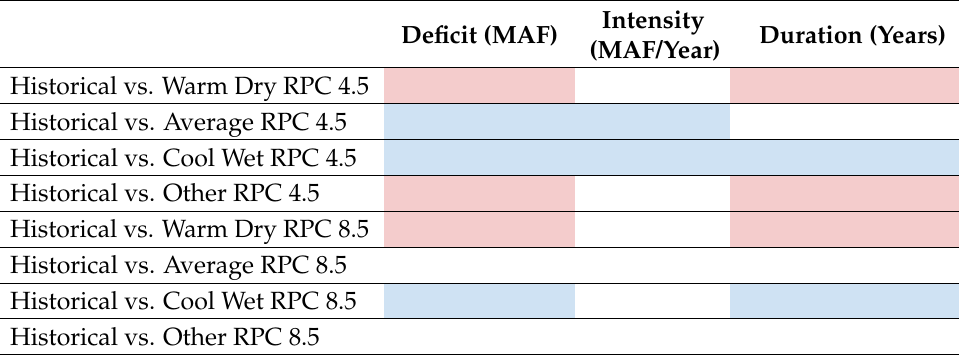
Table 1. Aggregated streamflow analysis using two tailed difference in means t -tests with a significant difference in drought categories. Highlighted boxes indicate a significant difference (at a 0.05 level) between historical (1950–2015) and model (2020–2099) projected means. Red represents a higher projected mean than historical. Blue represents a lower projected mean than